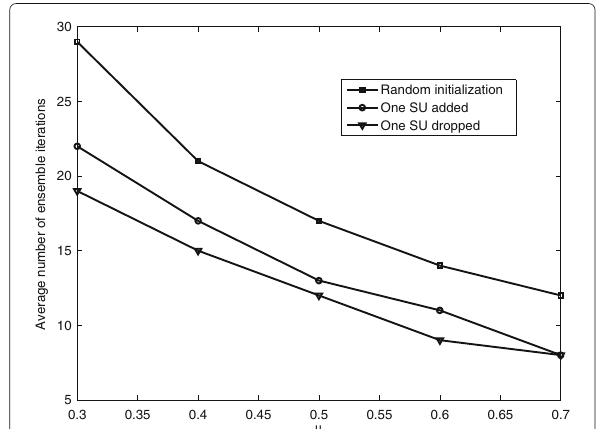
Fig. 11 The average number of ensemble iterations for convergence to the optimal NE for varying μ and fixed β = 0.5